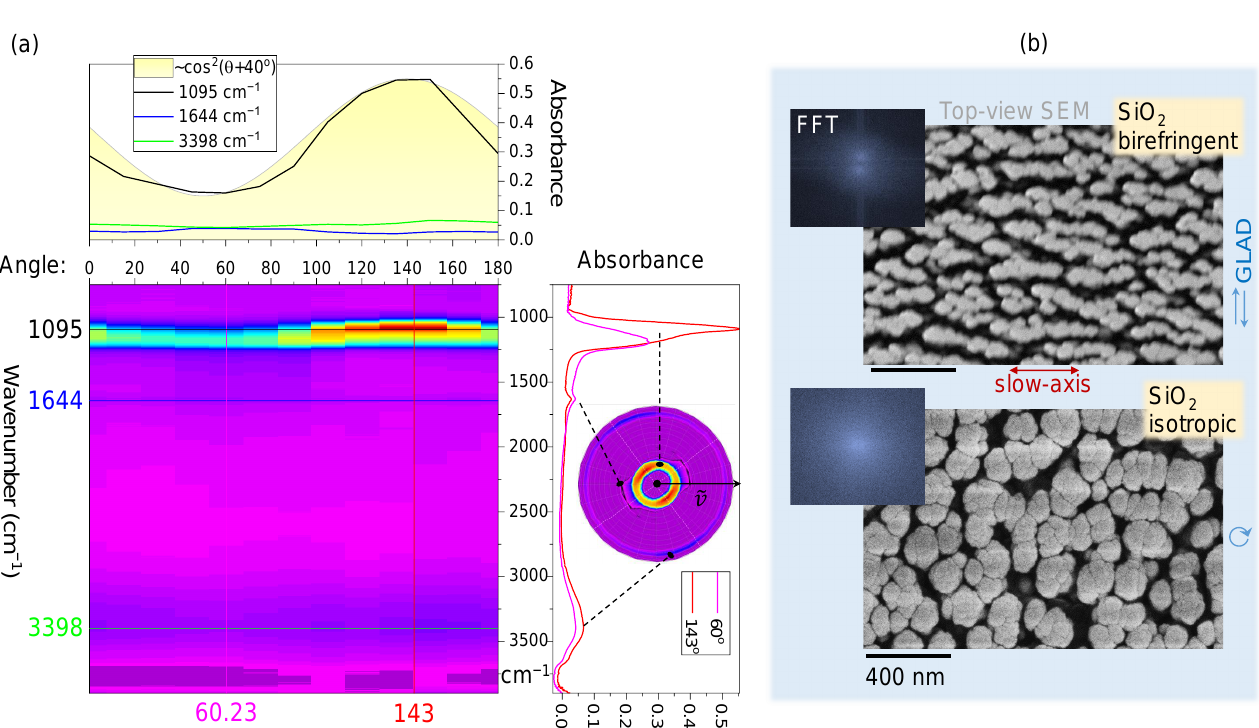
Figure 4. ( a ) The IR absorbance map of columnar SiO 2 on CaF 2 substrate with side-view cross sections of spectra at specific orientation angle θ , measured with the aligned polariser–analyser rotated around the sample. The ∼ cos 2 θ fit is the best match to the angular dependence of the Si-O-Si band at ˜ ν = 1095 cm − 1 . The inset in the absorbance spectrum cross section shows a 2 π -folded angular dependence map to highlight angular correlations between bands; ( b ) top-view SEM images of a birefringent SiO 2 columnar film (researched in another study and coated at 74 ◦ angle) and isotropic SiO 2 grown by GLAD at a constant rotation; see differences in FFT